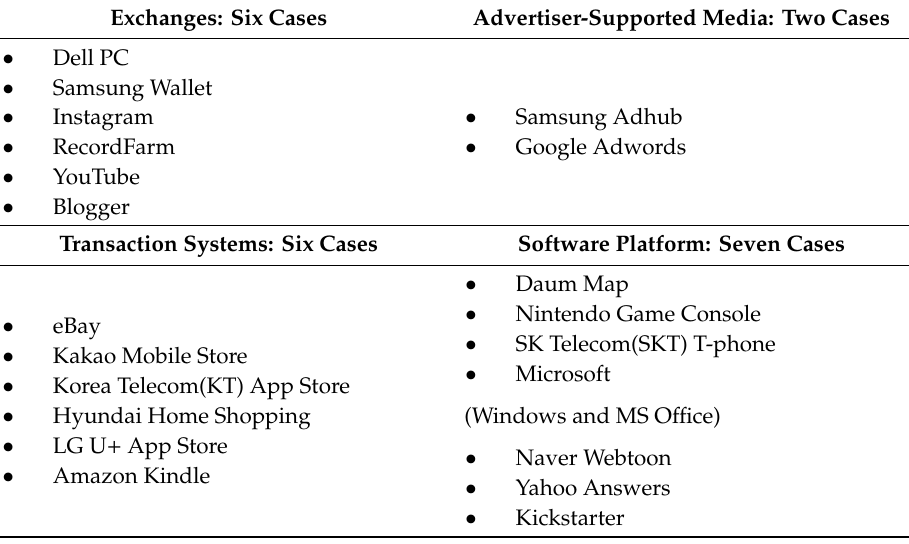
Figure A1. Case selections from business year to platform size. Table A1. Case selection from four di ff erent categories